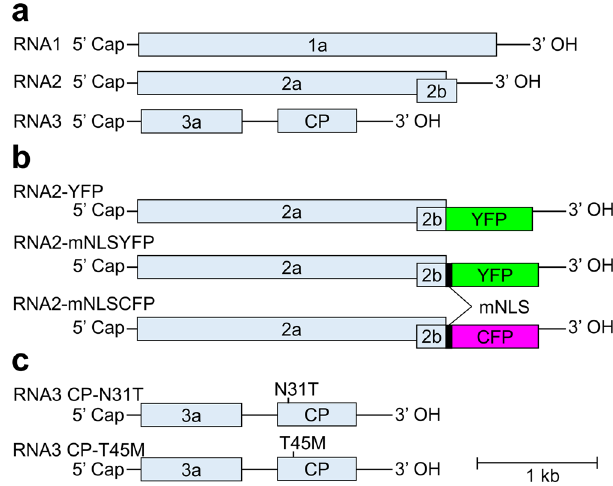
Fig. 1 Genome structure of cucumber mosaic virus (CMV) and its variants used in this study. a Genome structure of CMV. 1a and 2a proteins are replication proteins; 2b, an RNA-silencing suppressor; 3a, cell- to-cell movement protein; CP capsid protein. b RNA2 variants. Yellow and cyan fl uorescent protein (YFP and CFP, respectively) were produced as fusion proteins to the N-terminal 2b protein with and without modi fi ed nuclear localization signal (mNLS) peptide. c RNA3 variants with 1-aa